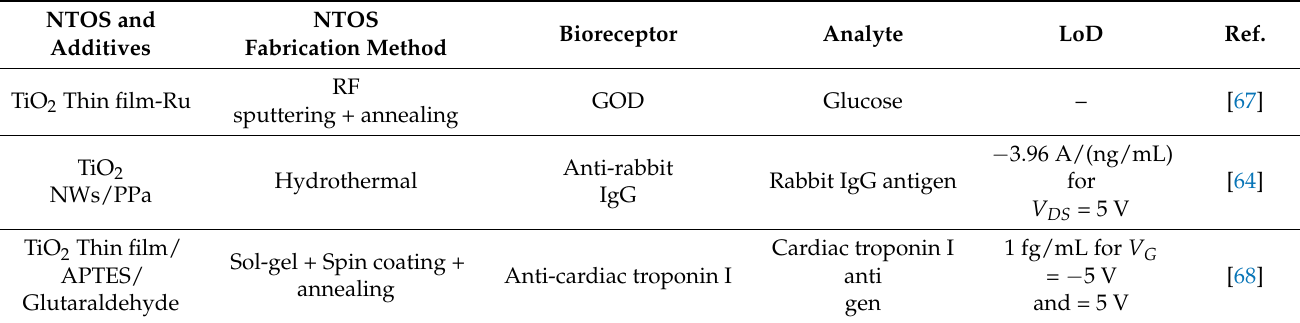
Table 4. FET biosensor based on